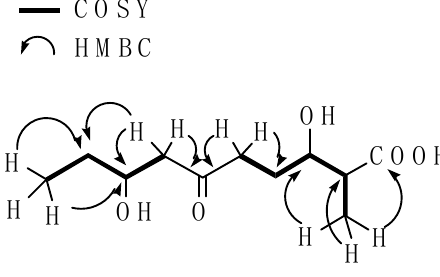
a 400 MHz. b 100 MHz. c obtained from the HMBC spectrum.